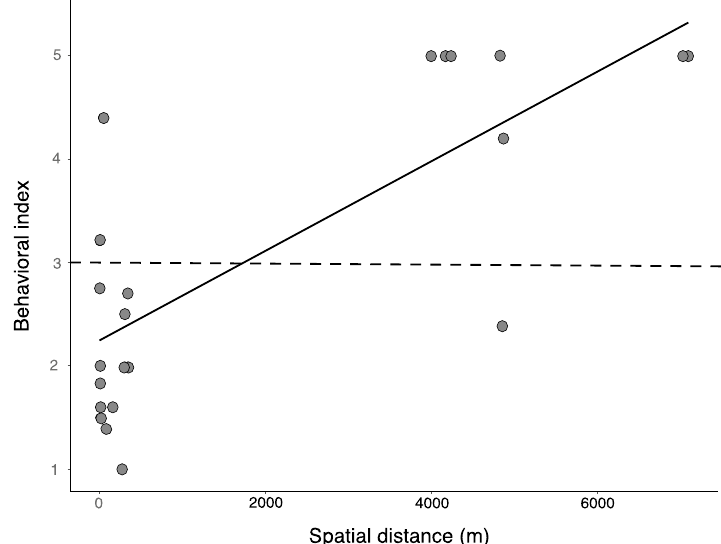
Figure 3. Relationship between the spatial distance and the ants’ behavioral index. Each point represents a pair of ant nests (five individuals per nest submitted to behavioral trials, N = 23). The solid line represents the linear regression fit to the data. The doted horizontal line indicates the threshold between non-aggressive (bellow the line) and aggressive (above de line) behaviors.